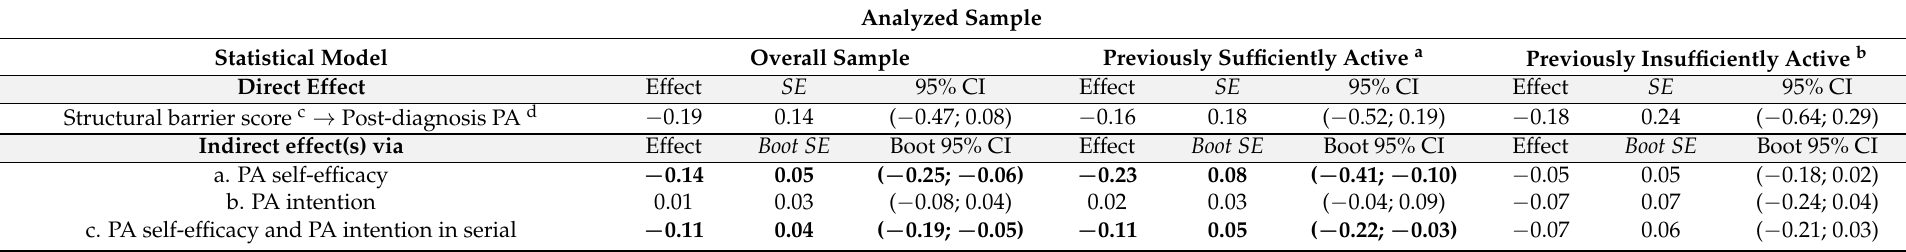
Table 3. Mediation analyses testing the direct and indirect effects of structural barriers on post-diagnosis physical activity via physical activity self-efficacy and physical activity intention in the overall sample and in subsamples divided by pre-diagnosis physical